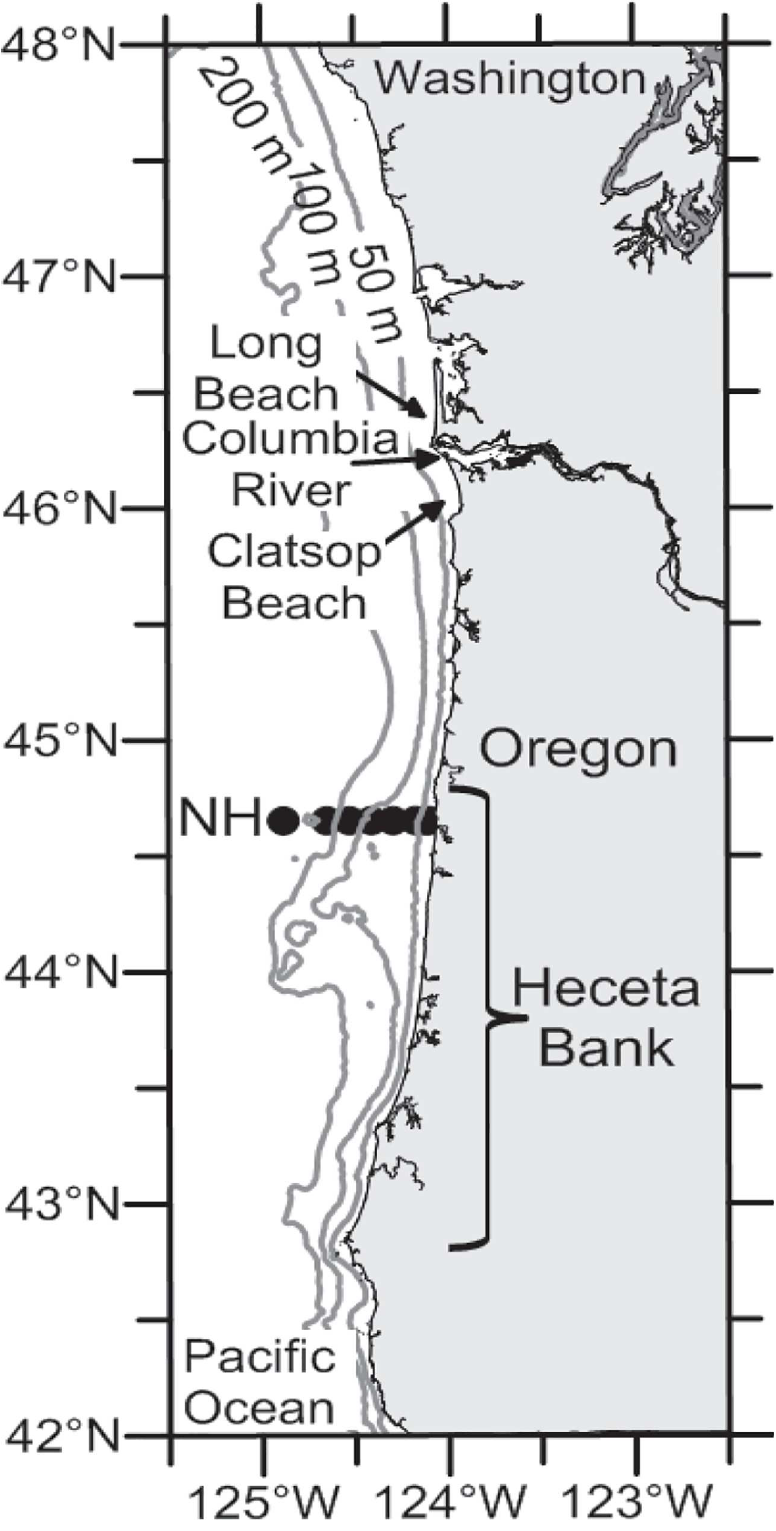
Fig 1. Shipboard sampling stations. Seven stations (black dots) are located sequentially from nearshore to the continental slope along the Newport Hydrographic (NH) line, central Oregon.